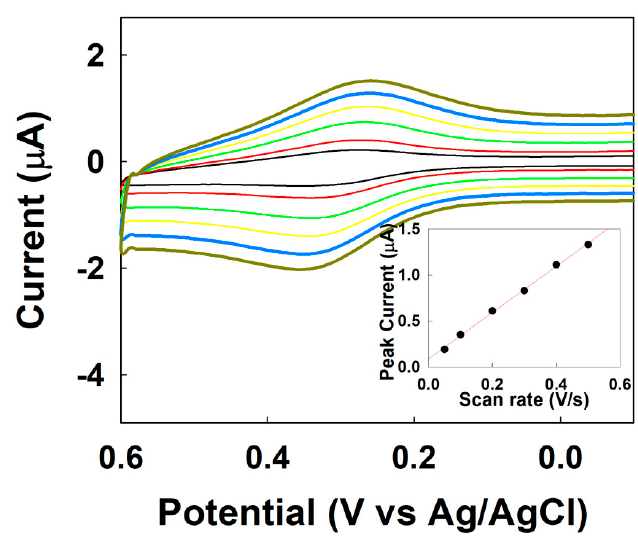
Figure 1. Cyclic voltammograms of the Fc SAM-modified ITO electrode with various scan rates in the electrolyte solution. Inset is a plot of the oxidation peak current as a function of the scan rate.